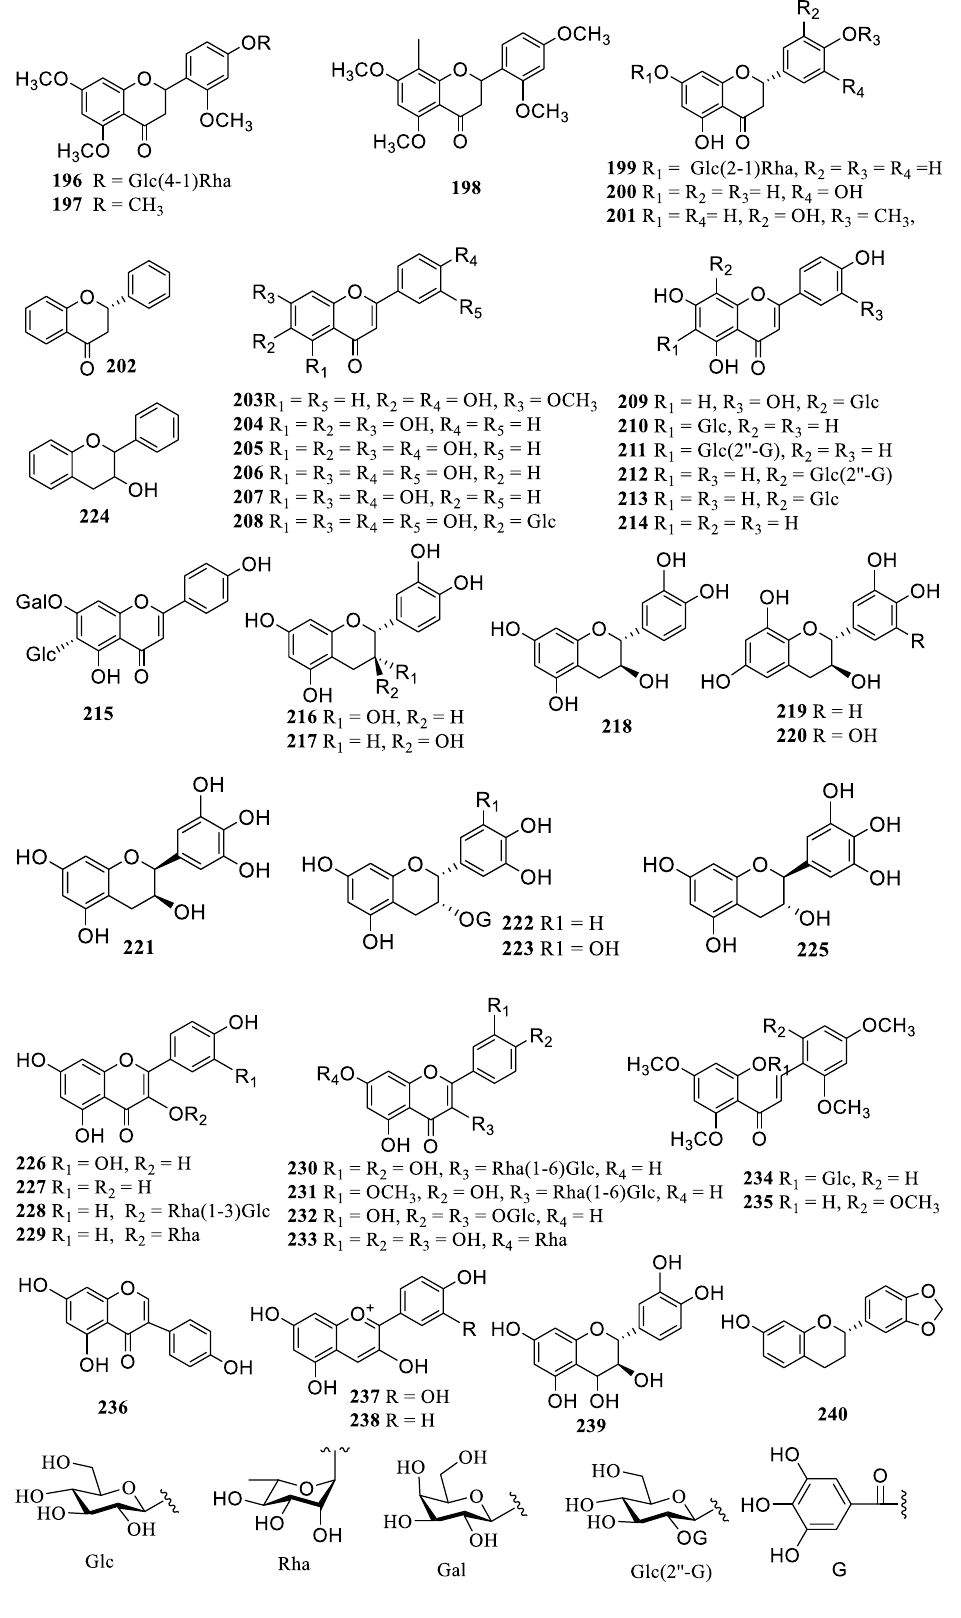
Fig. 3 The structures of flavonoids